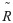
Comparisons of the PSL when R˜ is varied.